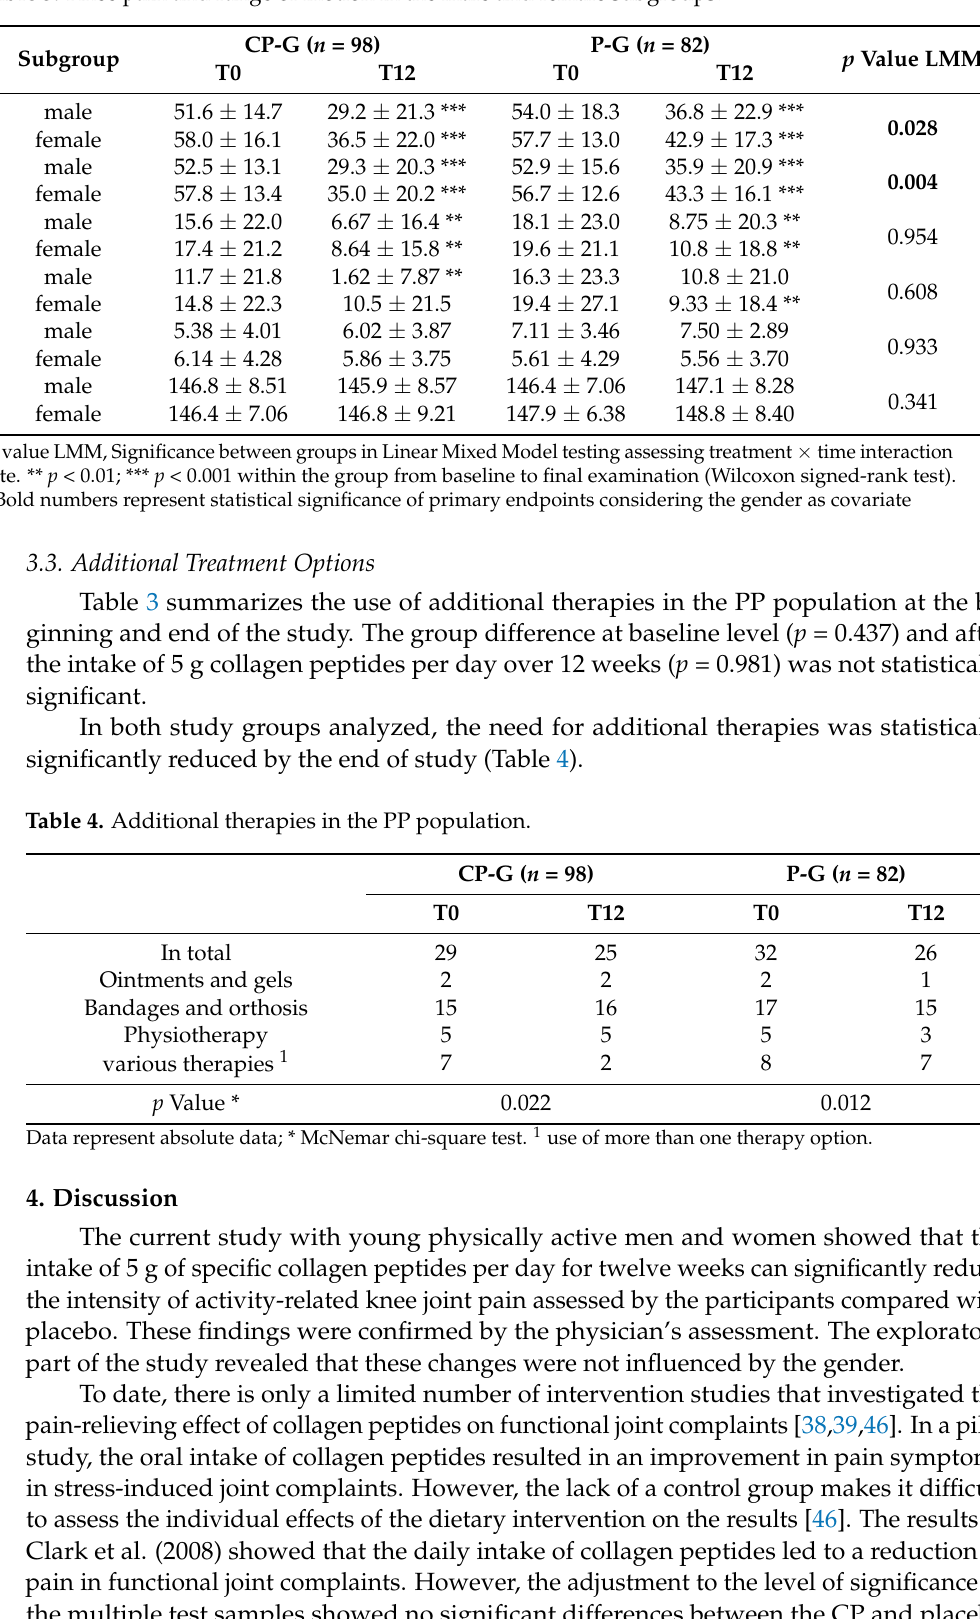
Table 3. Knee pain and range of motion in the male and female subgroups.